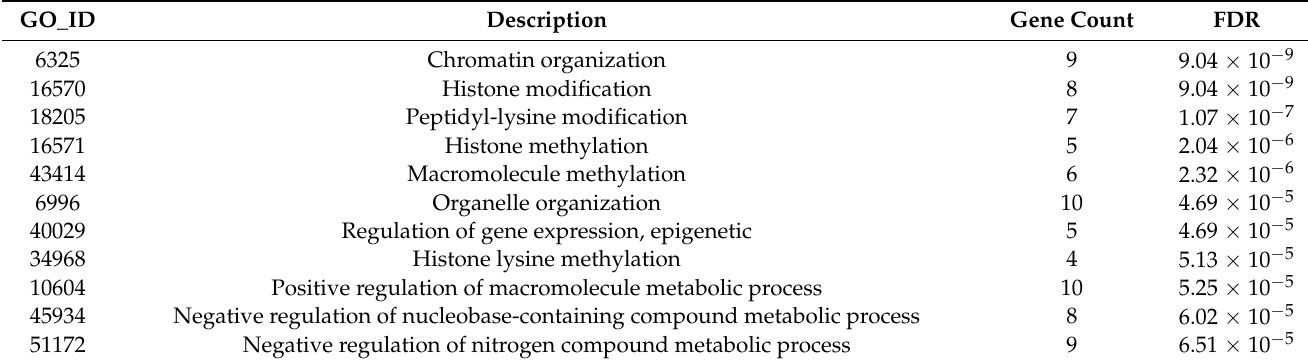
Table 2. Description of outstanding biological processes obtained from the network constructed with the genes significantly associated with chromatin modifications in vastus lateralis